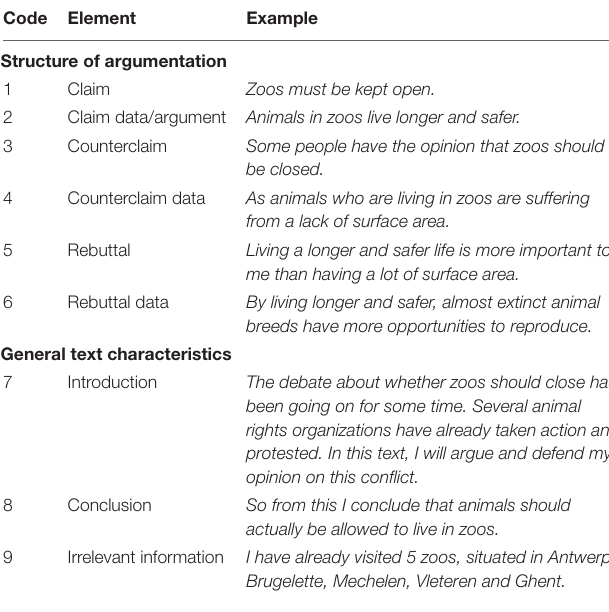
TABLE 5 | Overview of the codes corresponding to each unit of